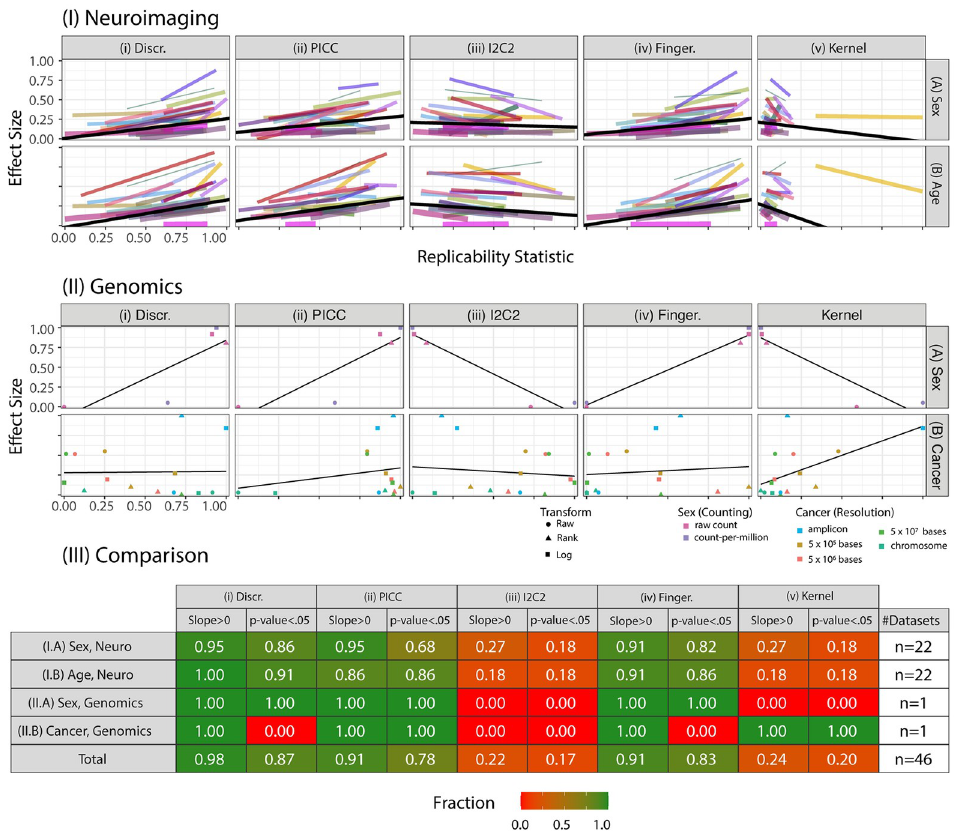
Fig 5. Optimizing Discr improves downstream inference performance. Using the connectomes from the 64 pipelines with raw edge-weights, we examine the relationship between connectomes vs sex and age. The columns evaluate difference approaches for computing pipeline effectiveness, including (i) Discr , (ii) PICC , (iii) Average Fingerprint Index Fingerprint , (iv) I2C2 , and (v) Kernel . Each panel shows reference pipeline replicability estimate ( x-axis ) versus effect size of the association between the data and the sex, age, or cancer status of the individual as measured by DCorr ( y-axis ). Both the x and y axes are normalized by the minimum and maximum statistic. These data are summarized by a single line per study, which is the regression of the normalized effect size onto the normalized replicability estimate as quantified by the indicated reference statistic. (I) The results for the neuroimaging data, as described in Section 3.4. Color and line width correspond to the study and number of scans, respectively (see Fig 3B). The solid black line is the weighted mean over all studies. Discr is the only statistic in which nearly all slopes are positive. Moreover, the corrected p -value [51, 52] is significant across most datasets for both covariates ( 39 values < .001). This indicates that pipelines with higher Discr correspond to larger effect sizes for the covariate of interest, and that this relationship is stronger for Discr than other statistics. A similar experiment is performed on two genomics datasets, measuring the effects due to sex and whether an individual has cancer. (III) indicates the fraction of datasets with positive slopes and with significantly positive slopes, ranging from 0 (“None”, red) to 1 (“All”, green), at both the task and aggregate level. Discr is the statistic where the most datasets have positive slopes, and the statistic where the most datasets have significantly positive slopes, across the neuroimaging and genomics datasets considered. S6 Text details the methodologies